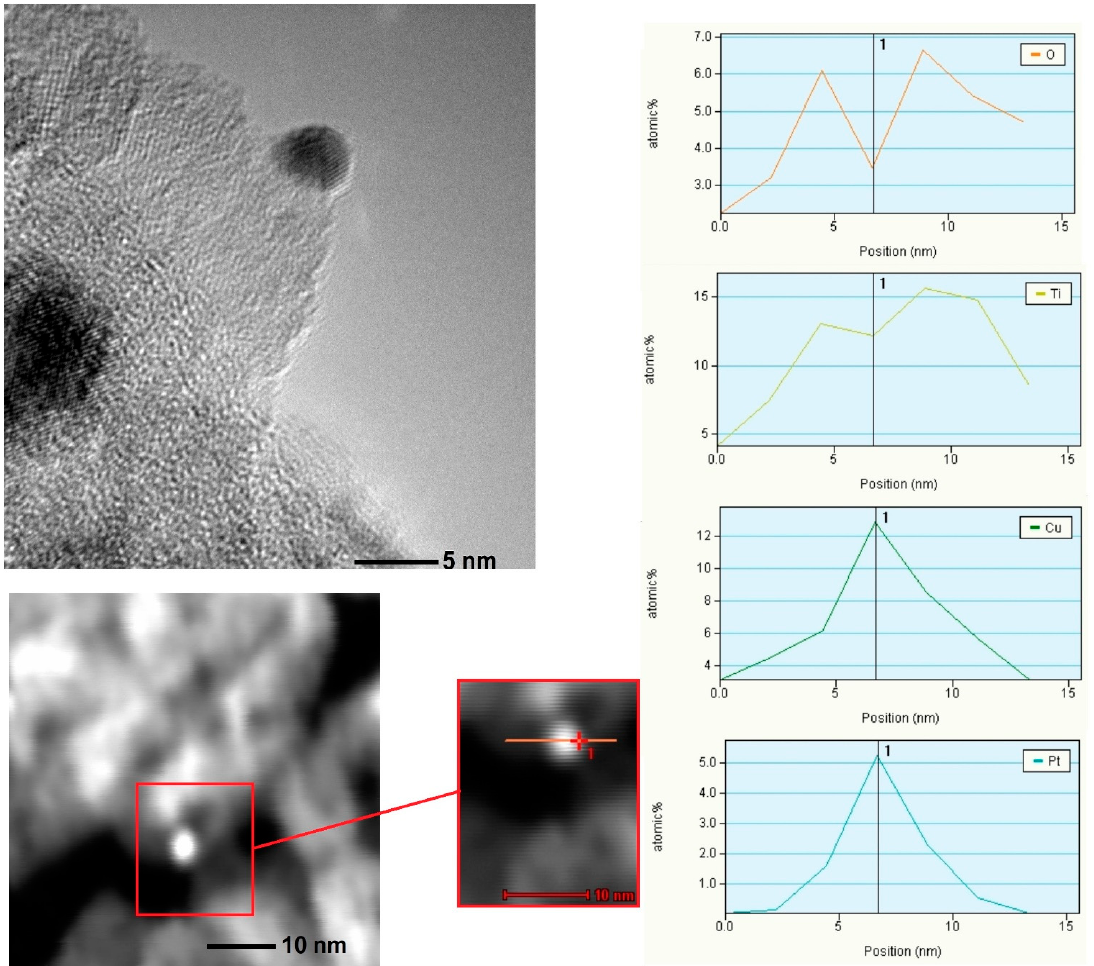
Figure 4. TEM images and line analysis’’of Cu/Pt-TiO 2 _2_C.